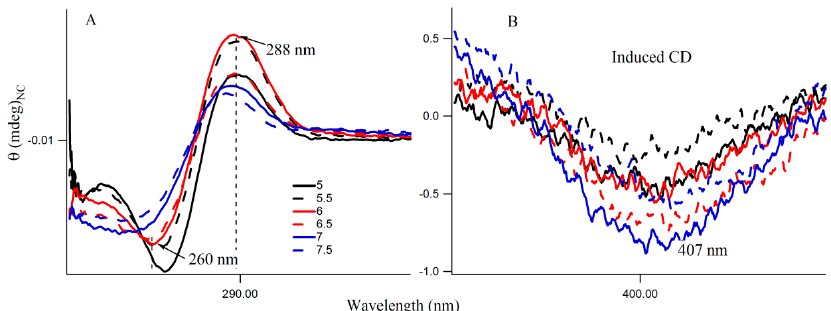
Figure 6. ( A , B ) Circular Dichroism (CD) spectra of 15 μ M 3T4G template with 90 μ M AgNO 3 with 90 μ M NaBH 4 in citrate buffer at different pH. The region between 350 and 450 nm is enlarged in Figure ( B ).